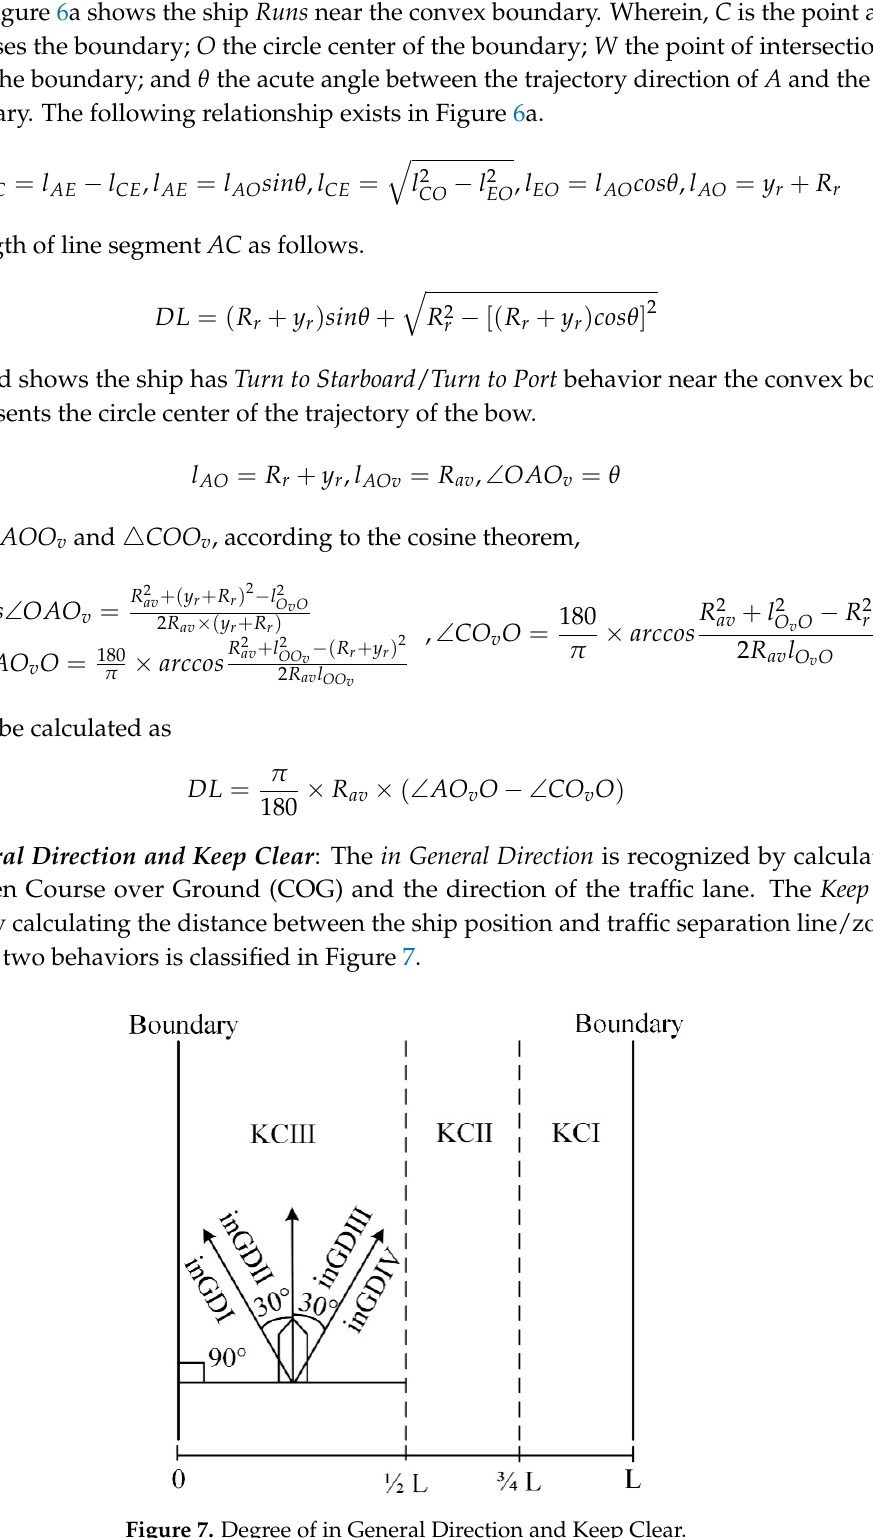
Figure 7. Degree of in General Direction and Keep Clear.